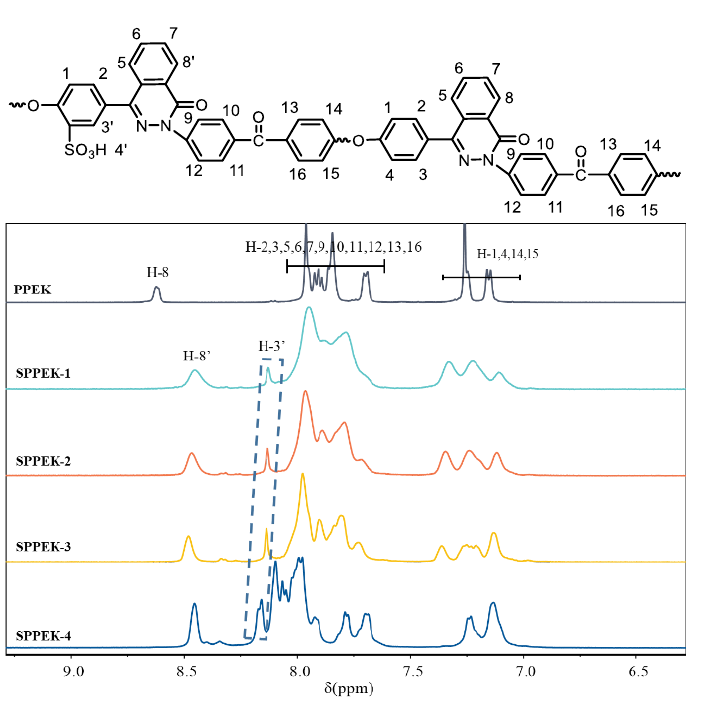
Figure 4. 1 H-NMR spectra of PPEK and SPPEK. Table 1. The conditions and results of sulfonation reaction.